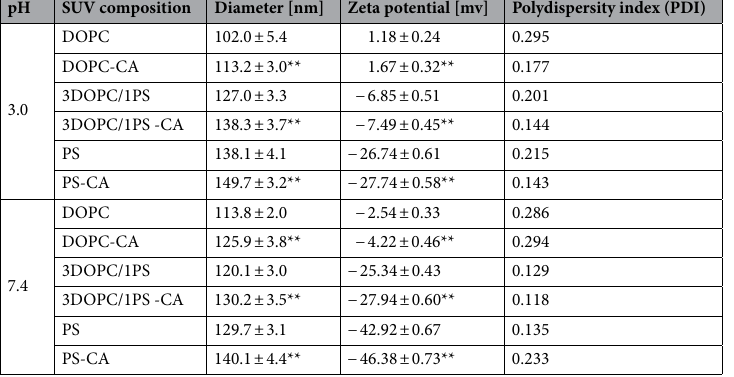
Table 2. Physicochemical characterization of DOPC, 3DOPC/1PS, and PS SUVs, pure and modified with 1 mmol/L of caffeic acid, at pH 3.0 and pH 7.4. Statistical difference in comparison to pure SUVs ** p <